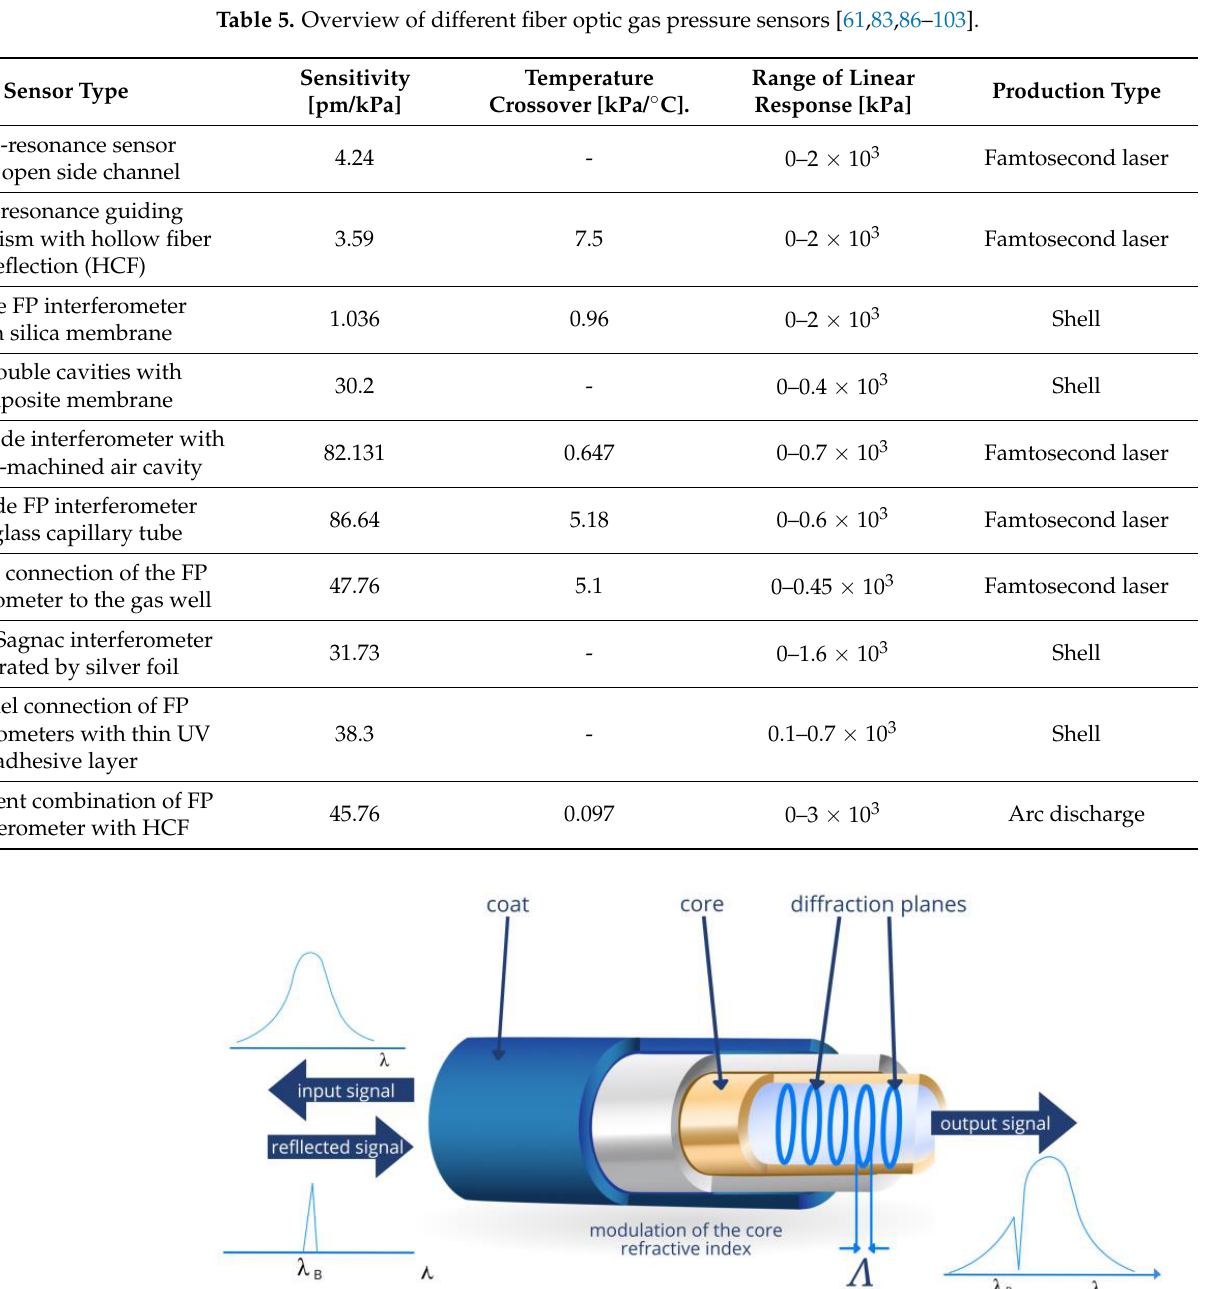
Figure 9. Optical Bragg grating structure [96].